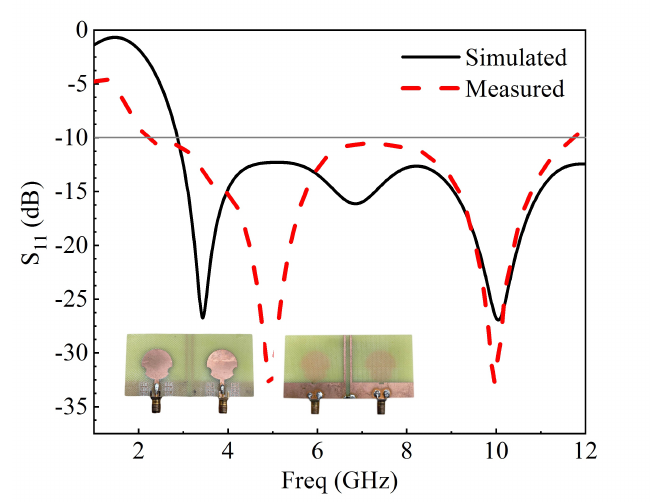
Figure 21. Measured and simulated S 11 of the designed antenna.